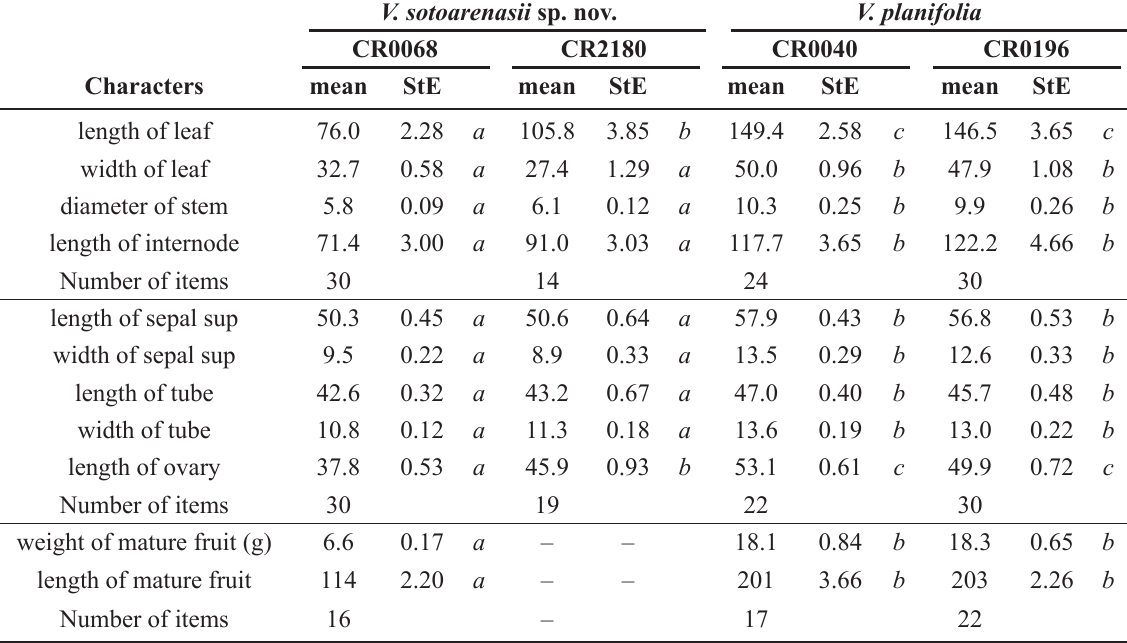
Table 4. Means of different measurements on vegetative and reproductive organs of two accessions of Vanilla sotoarenasii M.Pignal, Azofeifa-Bolaños & Grisoni sp. nov. (CR0068 and CR2180) and two accessions of V. planifolia Jacks. ex Andrews (CR0040 and CR0196). Measurements are in mm unless otherwise indicated. In each line, means with different letters are significantly different (p < 0.005, Tukey’s test). StE = standard error.